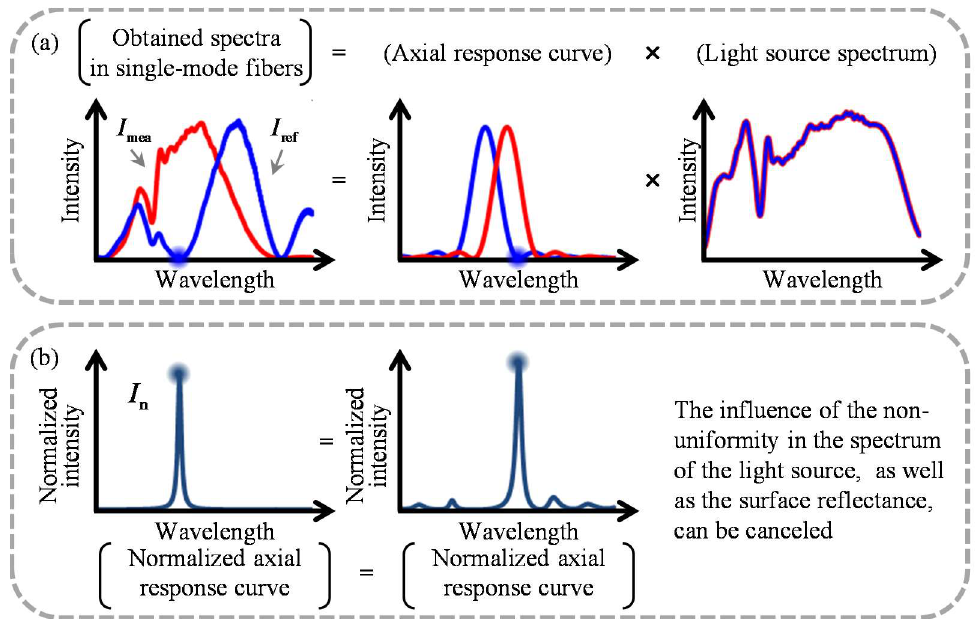
Figure 4. Schematics of detected spectra by a fiber-based dual-detector. ( a ) An example of the spectra obtained by the pair of single-mode fibers; ( b ) The normalized axial response curve I n obtained by I mea and I ref shown in ( a ).